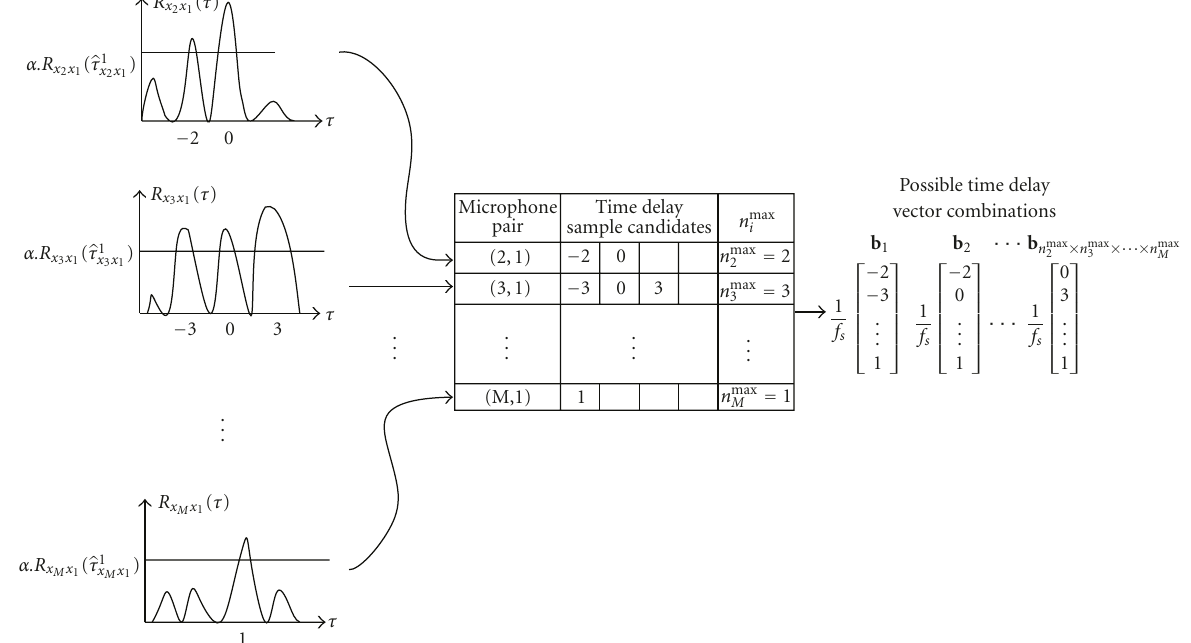
Figure 4: Illustration of the procedure of forming possible time delay vector